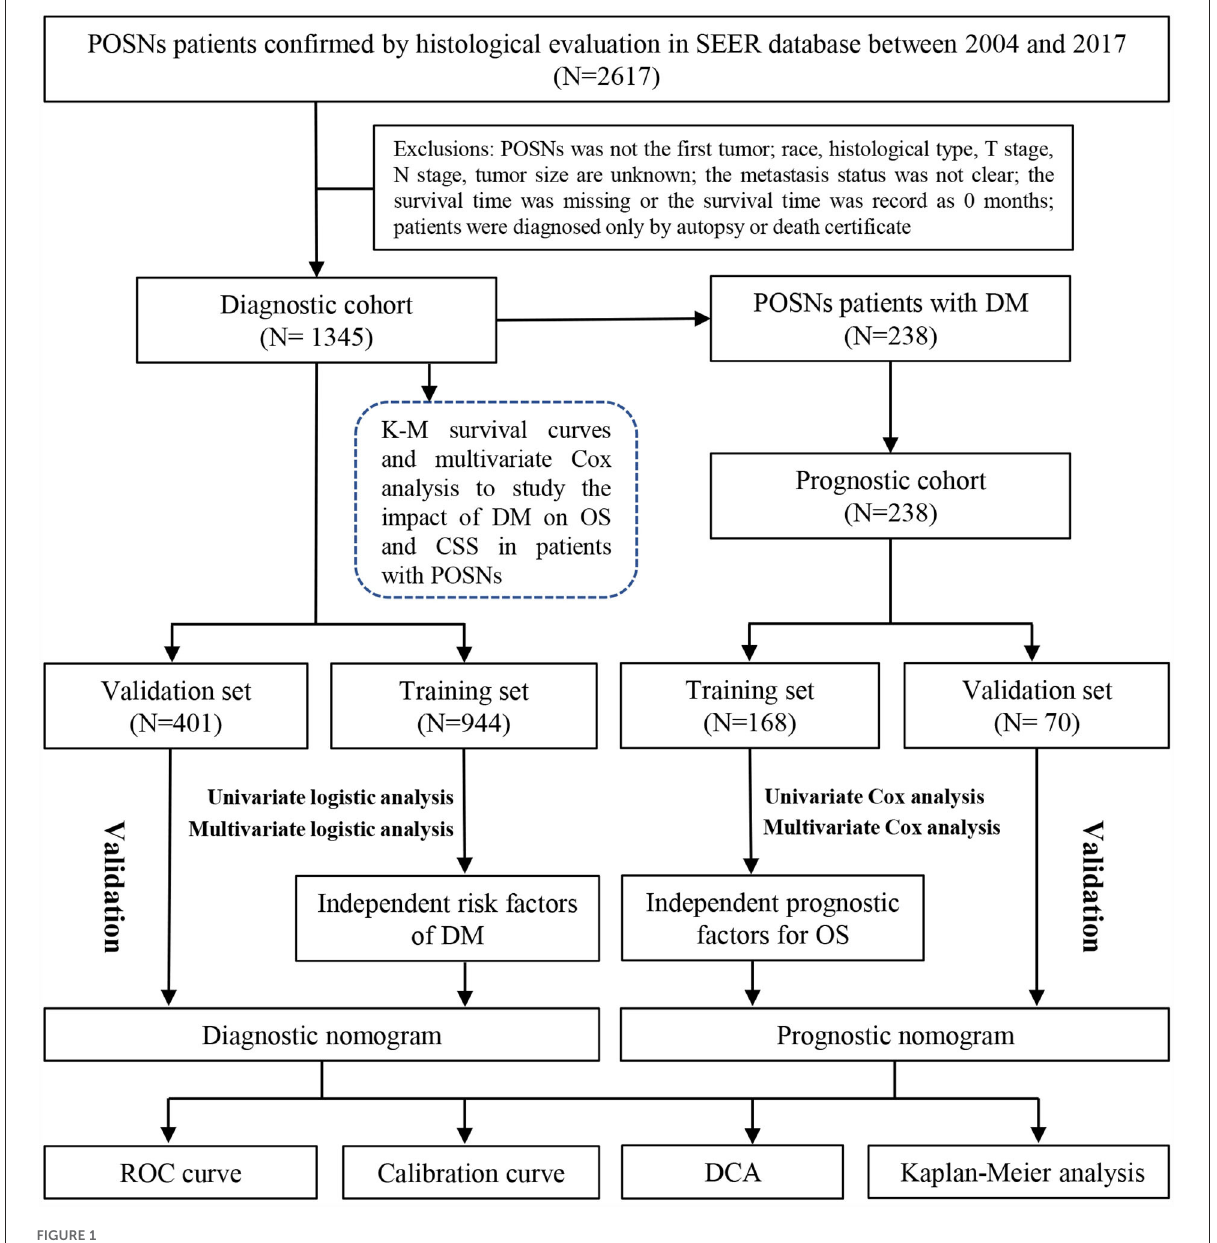
FIGURE1 Patients’ selection and workflow of this